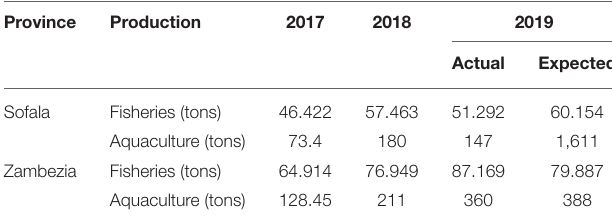
TABLE 1 | Previous production (in tons) statistics in the two provinces in Mozambique affected by the cyclones ( MIMAIP, 2020).